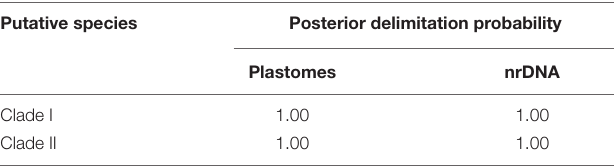
TABLE 4 | Posterior delimitation probability of two putative species proposed by mPTP analyses of complete plastomes and nuclear ribosomal DNA (nrDNA) sequences.